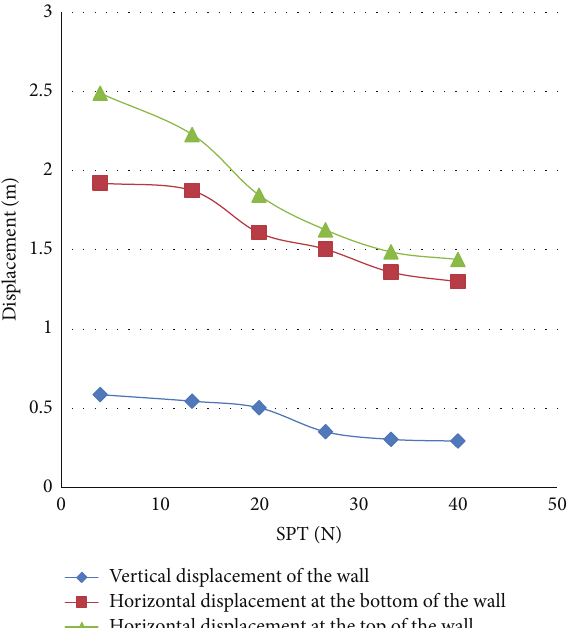
Figure 8: Horizontal and vertical displacements of the quay wall versus the SPT number for the wall of 8 meters wide.